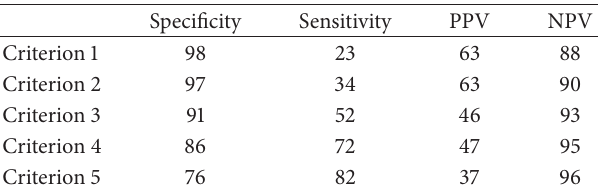
Table 4: The ability of the five criteria to predict insignificant PC in RP specimen.